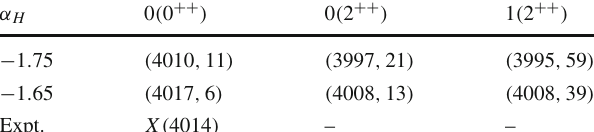
Table 3 The resonance parameters ( m ,(cid:5)) in unit of MeV for the dif- ferent I ( J PC ) cases depending on the parameter α H